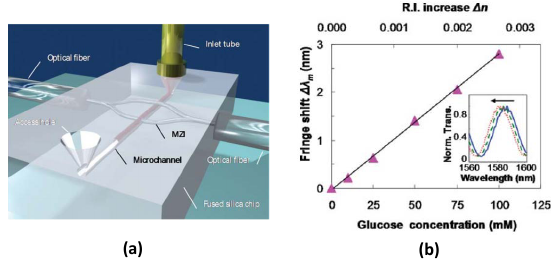
Figure 13: (a) Three-dimensional schematic illustration of optoflu- idics fabricated by femtosecond laser 3D processing to perform label-free spatially selective sensing of liquid samples. The sens- ing arm in the MZI crosses the channel orthogonally, while the reference arm passes over it. (b) Measured fringe shift for vari- ous glucose-D concentrations (inset: solid line 0 mM; dashed line 50 mM; dotted line 100 mM) measured using the fabricated optoflu- idic system with an unbalanced MZI. The top axis indicates the correspondent refractive index change [107]. Reproduced with per- mission from The Royal Society of Chemistry, © 2010 by The Royal Society of